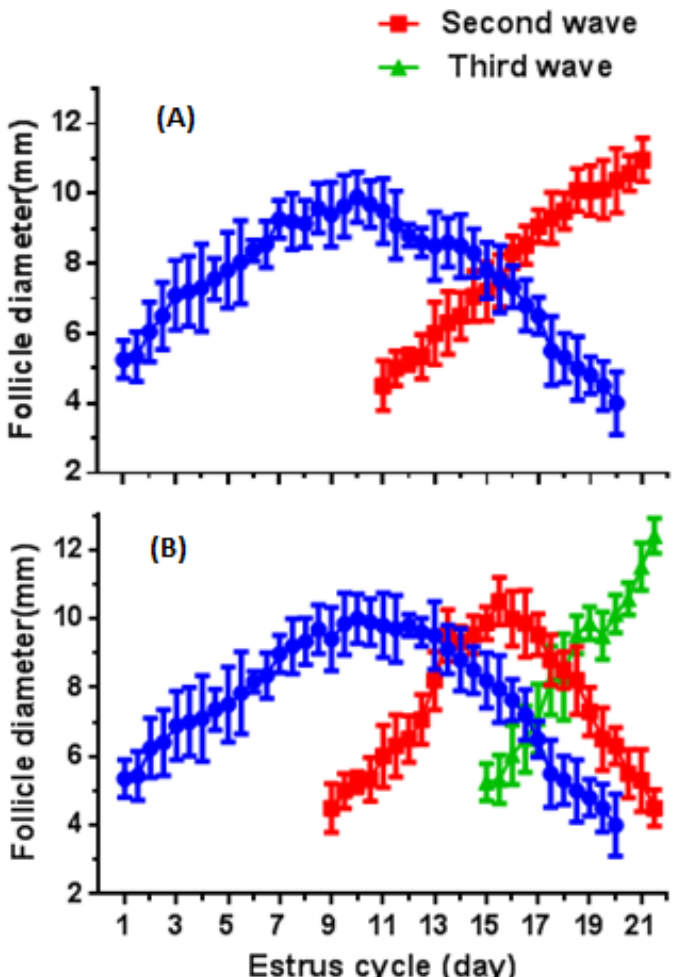
Figure 2. The growth profile of DF in sexually mature crossbred buffaloes with a two- (( A ), n = 20) and three-wave (( B ), n = 2) estrous cycle.